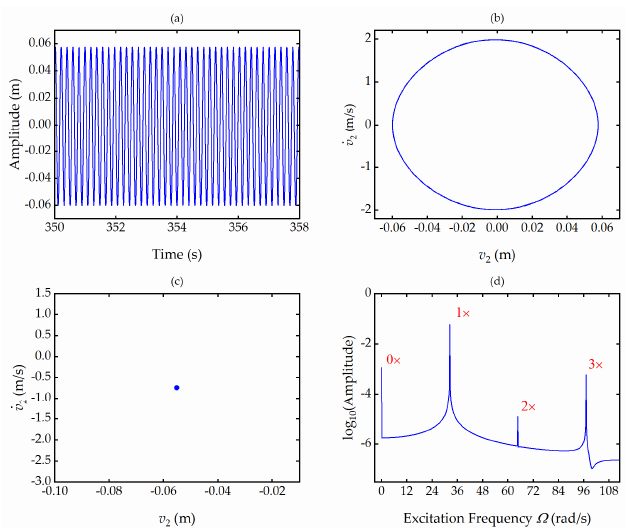
Figure 10. Response of a system with second − and third − order nonlinear terms for the case of w 0 = 0.0008 m, Ω = 32.34 rad/s: ( a ) Time history of steady state. ( b ) Phase portrait. ( c ) Poincare map. ( d ) Spectrum response.